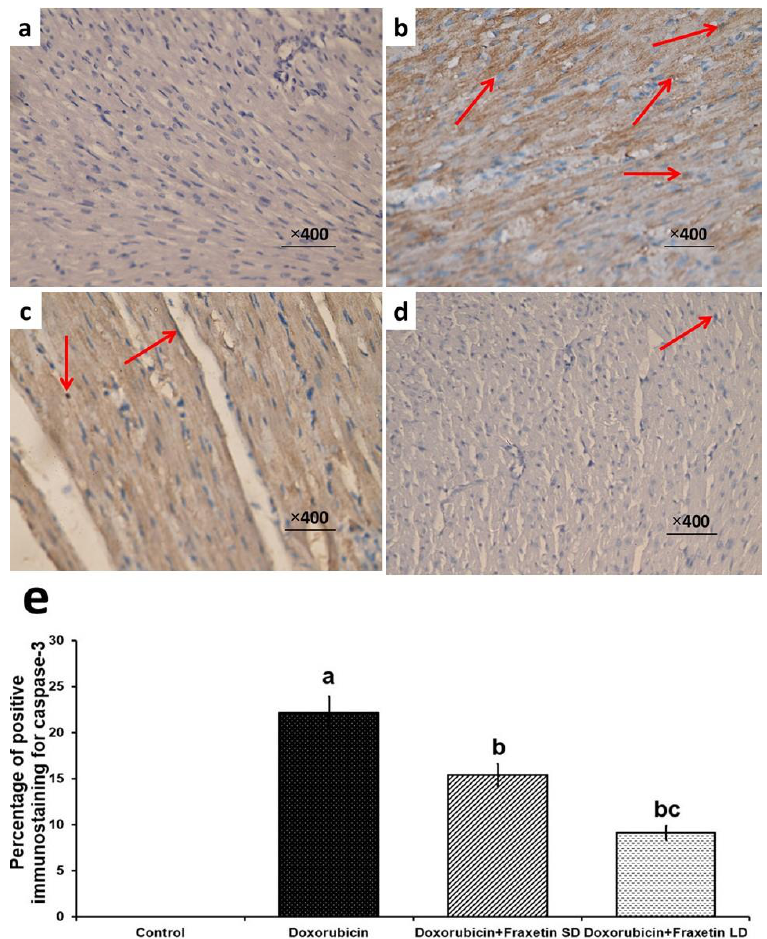
Figure 4. Immunohistochemical staining of caspase-3 in the left ventricle of ( a ) the control group showing negative immunoexpression of caspase-3; ( b ) Doxorubicin-treated group showing strong positive expression of caspase-3 in the form of deep brown discoloration of the cytoplasm of the cardiomyocytes (Arrows); ( c ) Doxorubicin + Fraxetin small dose group showing weak uptake of the stain by the cardiac myocytes, which appeared as mild brown discoloration of their cytoplasm (Arrow); ( d ) Doxorubicin + Fraxetin large dose group showing mild positive immunoexpression of caspase-3 (Caspase-3 ×400); and ( e ) Percentage of positive immunostaining for caspase-3 ( a Signifi- cant relative to the control group; b Significant relative to doxorubicin group; c Significant relative to doxorubicin + fraxetin small dose group). 3.6. Effect of Doxorubicin with or without Fraxetin on Echocardiographic Indices in the Studied Groups At the baseline of the study, the echocardiographic indices, including heart rate, LVEDD, LVESD, LVFS, LVEF, and MPI were within the normal range for all rats. At the end of the study, the group that was injected with doxorubicin alone exhibited significant increase in LVESD with significant decline in LVEF, LVFS, and MPI, compared to the control group. These changes were reversed with administration of the different doses of fraxetin but maximal improvement was pronounced in rats that received 80 mg/kg frax- etin. No significant differences were noticed regarding heart rate or LVEDD at the end of the study between the different groups (Table 3).